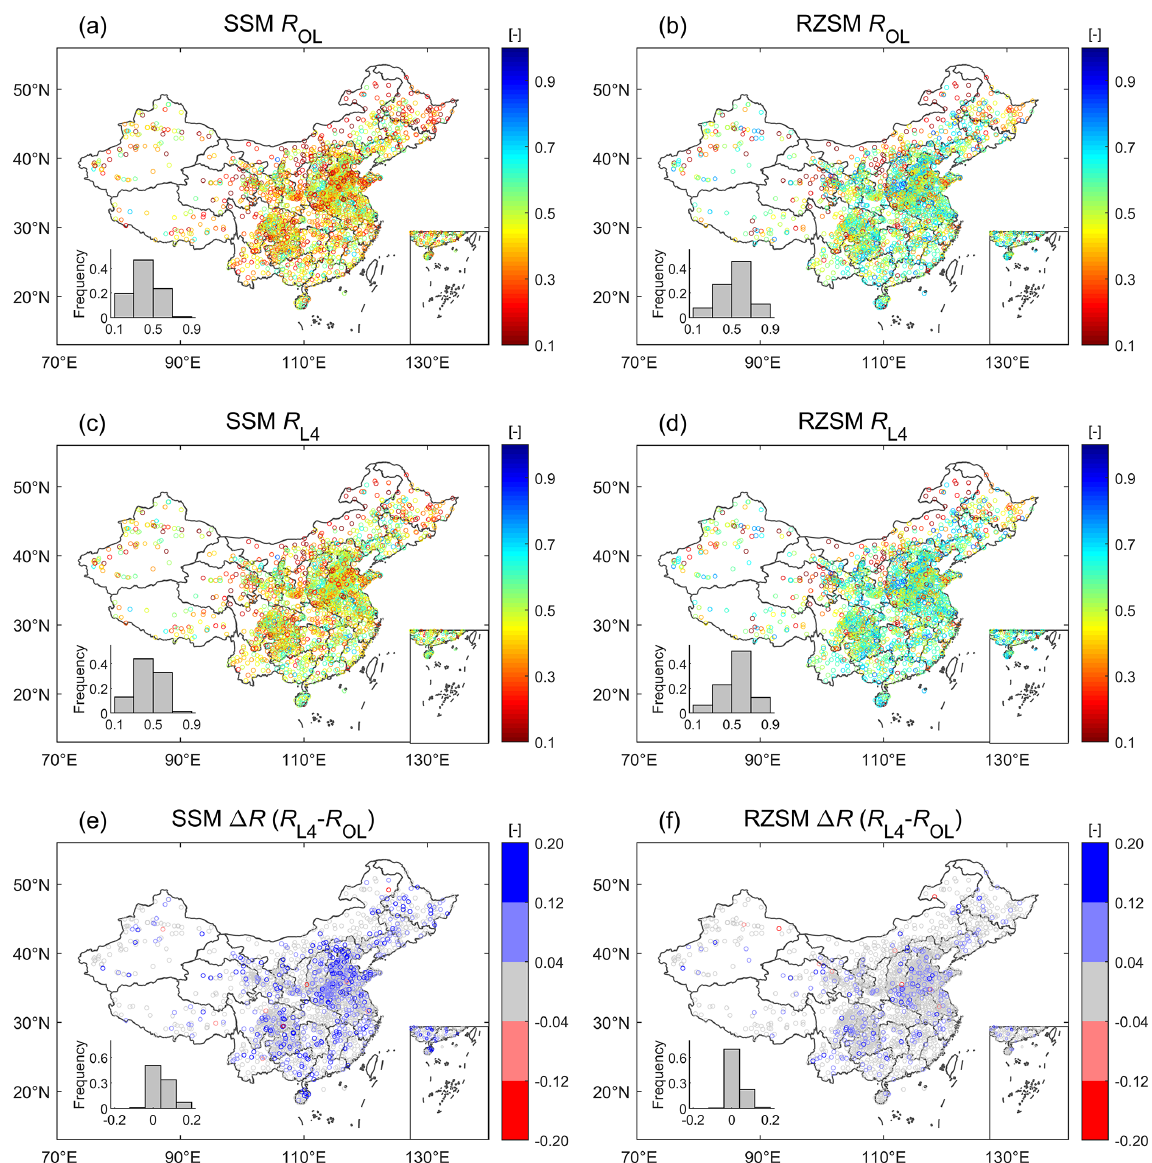
Figure 3. OL (a, b) and L4 (c, d) skills ( R values) for SSM (a, c, e) and RZSM (b, d, f) . DA skill improvement ( (cid:49)R = R L4 − R OL ) for (e) SSM and (f) RZSM. Blue (red) colors in (e) and (f) indicate grid cells where L4 estimates are better (worse) than OL. Non-significant differences (based on a 1000-member bootstrapping analysis) are shaded grey. The lower left inset in each subplot indicates the frequency of binned R values across all 9km EASE grid cells containing ground